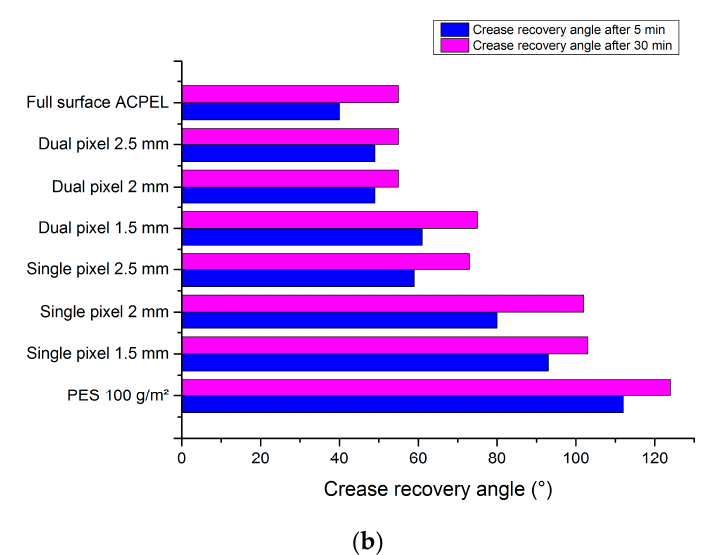
Figure 2. The air permeability ( a ) and the crease recovery angle ( b ) of the screen printed ACPEL devices on polyester textile substrates.